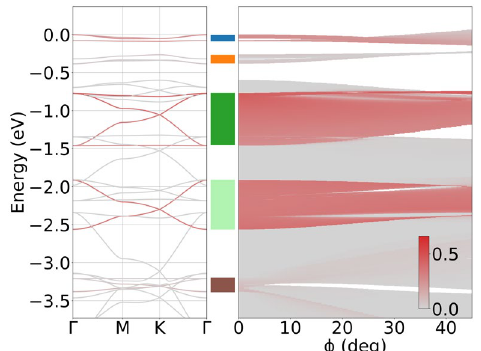
Figure 9. Band structure of COF-BS-1Ph (including projection on p z -orbitals at linker positions) and impact of rotation of the phenyl rings on band width and projection. The energy zero is set to the valence band maximum of the planar